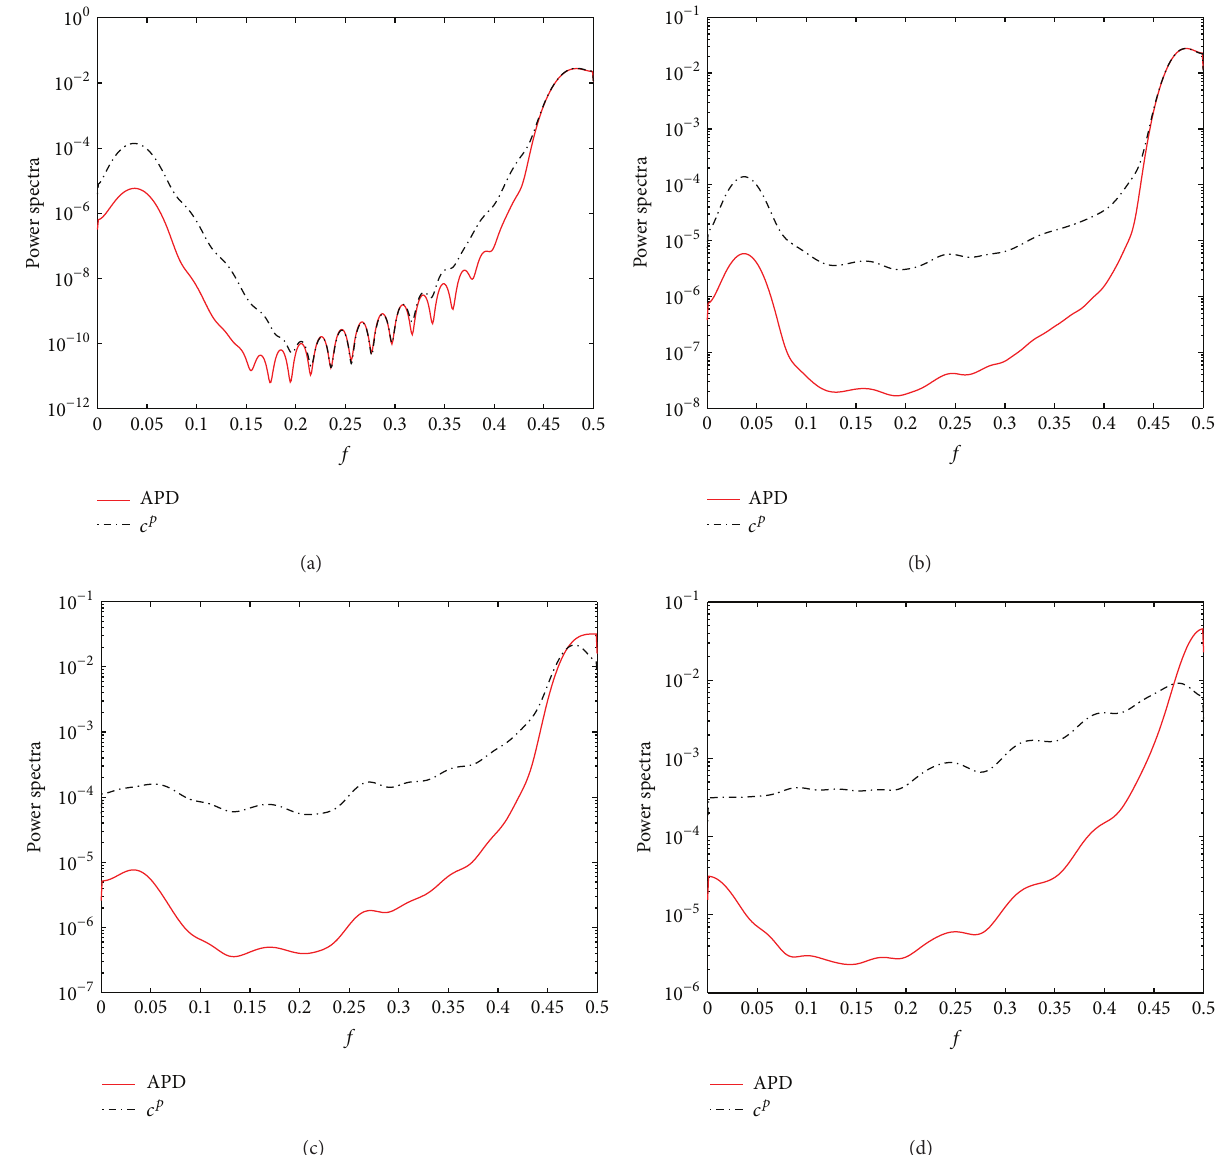
Figure 7: Power spectra of the coupled system (10) for the two corresponding time series obtained in Figure 3(b). (a) 𝜖 = 0 , (b) 𝜖 = 0.02 , (c) 𝜖 = 0.1 , and (d) 𝜖 = 0.5 . To facilitate comparisons, the spectra are normalized to unit